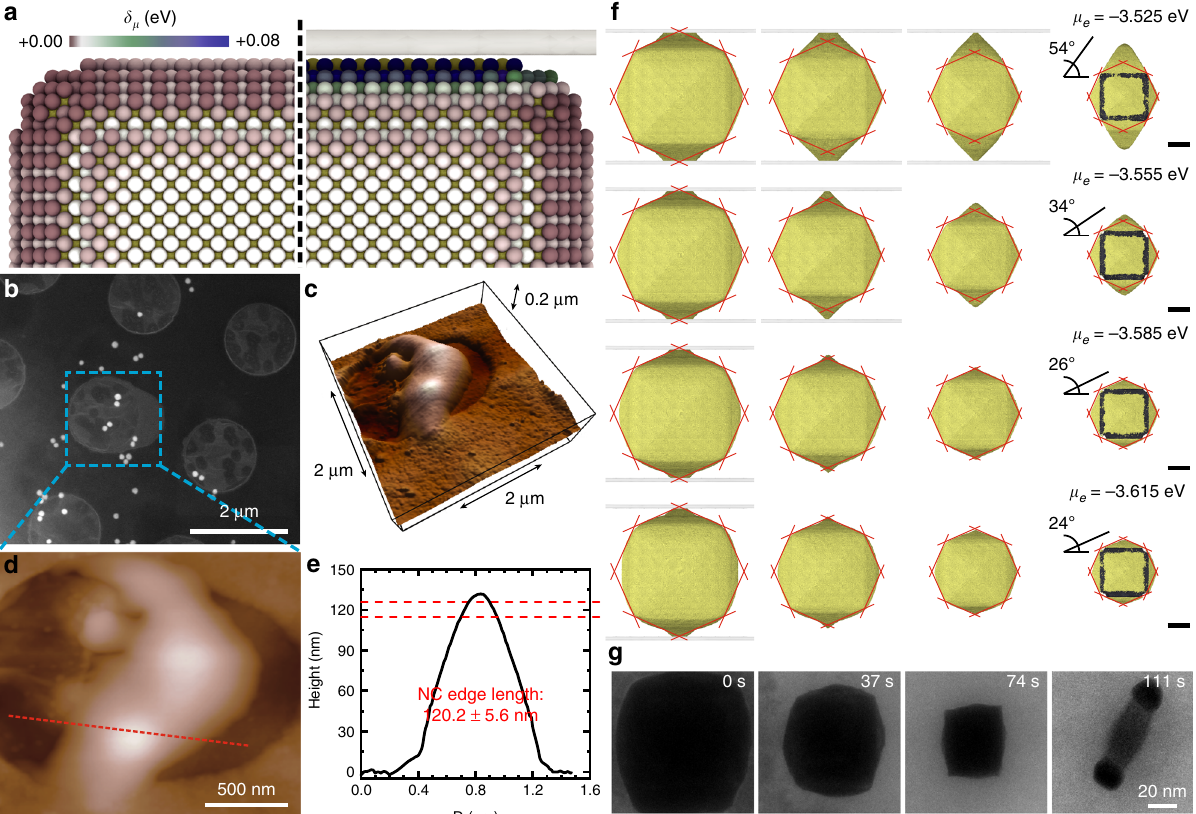
Fig. 4 Dissolution anisotropy of Pd@Au nanocubes induced by graphene encapsulation. a Effective chemical potential for surface Au atoms of a Pd@Au nanocube subject to isotropic (left) and anisotropic (right) oxidative environment due to a graphene sheet. b , c Correlative SEM b and AFM c images of the same GLC pocket. d High-resolution AFM height image of the region indicated in b . e Height pro fi le through the red dashed line indicated in d . f Simulations of anisotropic dissolution of Pd@Au nanocubes induced by top and bottom graphene sheets at different chemical potentials. g Time-lapse TEM images extracted from Supplementary Movie 6 showing the formation of a rod-like nanostructure due to preferential lateral dissolution of Pd@Au nanocubes (70-nm Pd core and 22-nm Au